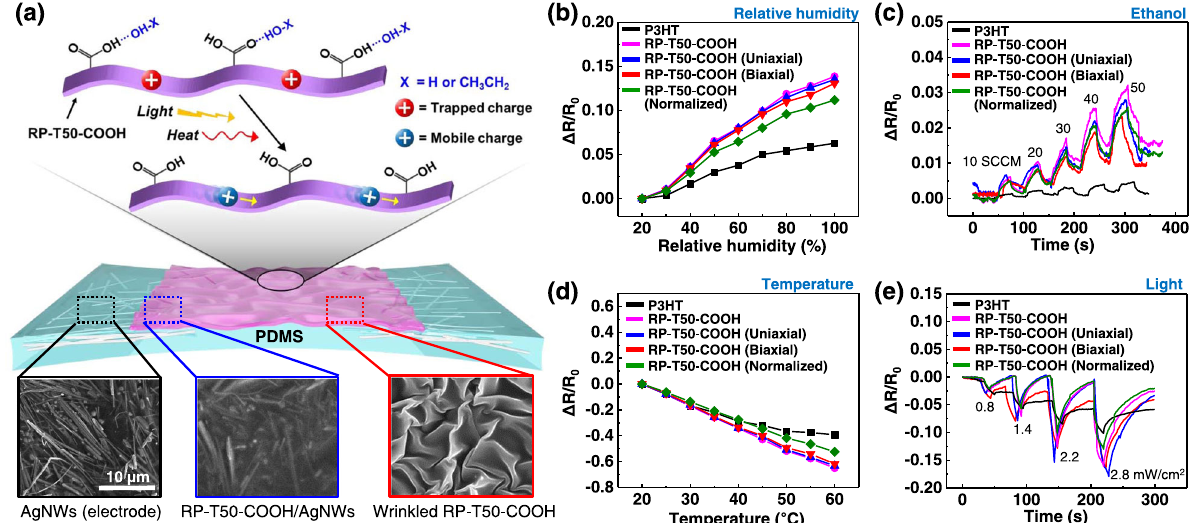
Fig. 5 Stretchable multifunctional sensor and sensing performance. a Schematic illustration of the structure and working mechanisms for the stretchable sensor. Inset: SEM images of the surface morphologies on each sensor part. Resistance changes as a function of relative humidity ( b ), ethanol fl ow ( c ), temperature, ( d ) and light intensity ( e ) of fl at P3HT and wrinkled RP – T50 – COOH fi lms. Wrinkled RP – T50 – COOH fi lms under pristine state, uniaxially stretched state (50%), and biaxially stretched state (30%) are compared. In addition, normalized resistance changes of RP – T50 – COOH fi lm under pristine state (i.e., normalized by the dimensionless factor of the initial surface area over the wrinkled surface area) is also